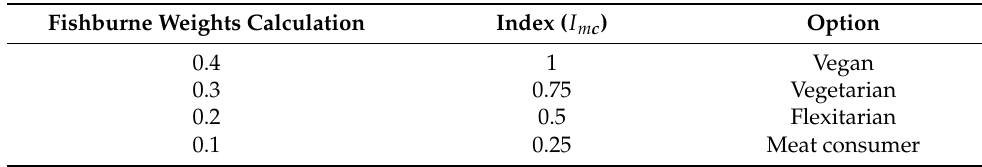
Table 7. Index system for type of meat